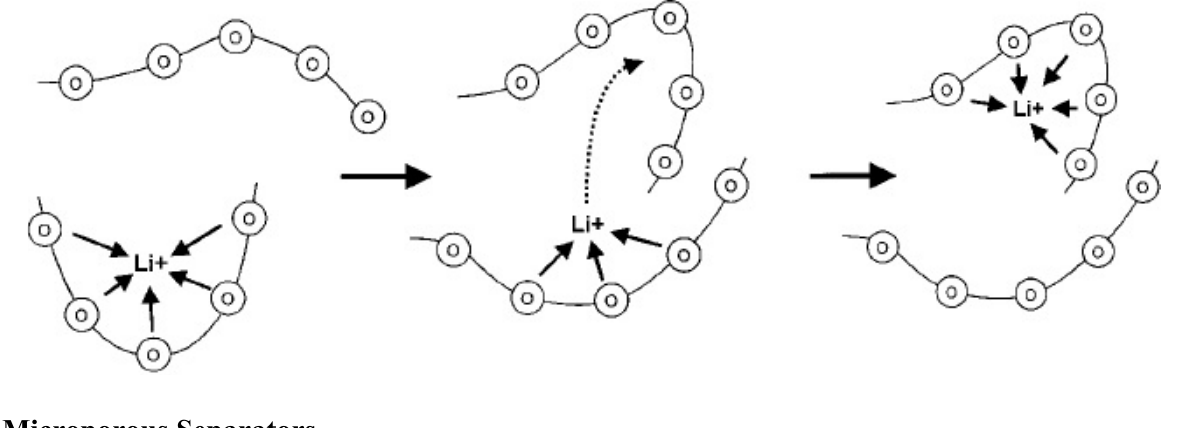
Figure 7. Schematic of the segmental motion assisted diffusion of Li ions in the poly(ethylene oxide) (PEO) matrix. The circles represent the ether oxygens of PEO